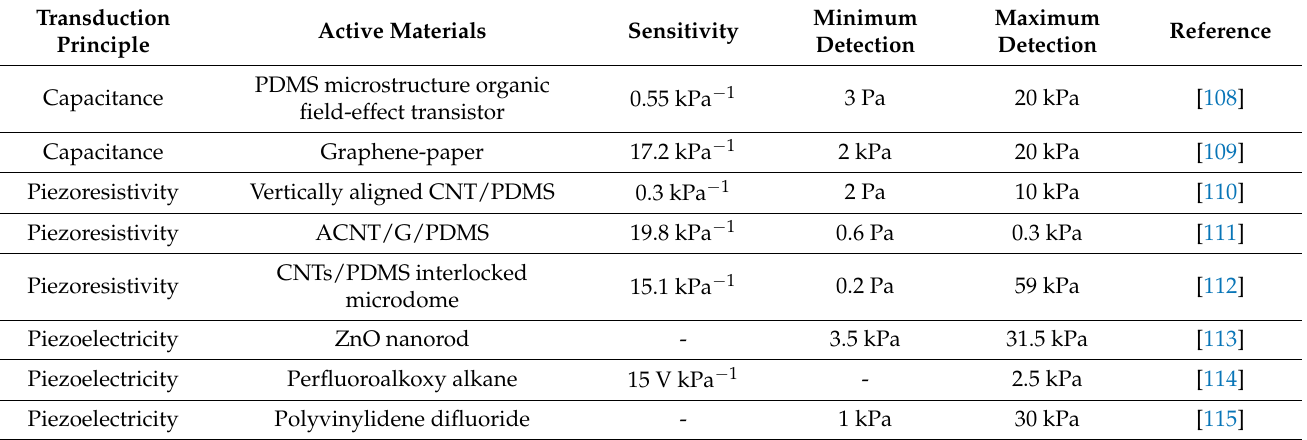
Table 2. A summary of the reported performance of flexible pressure sensors